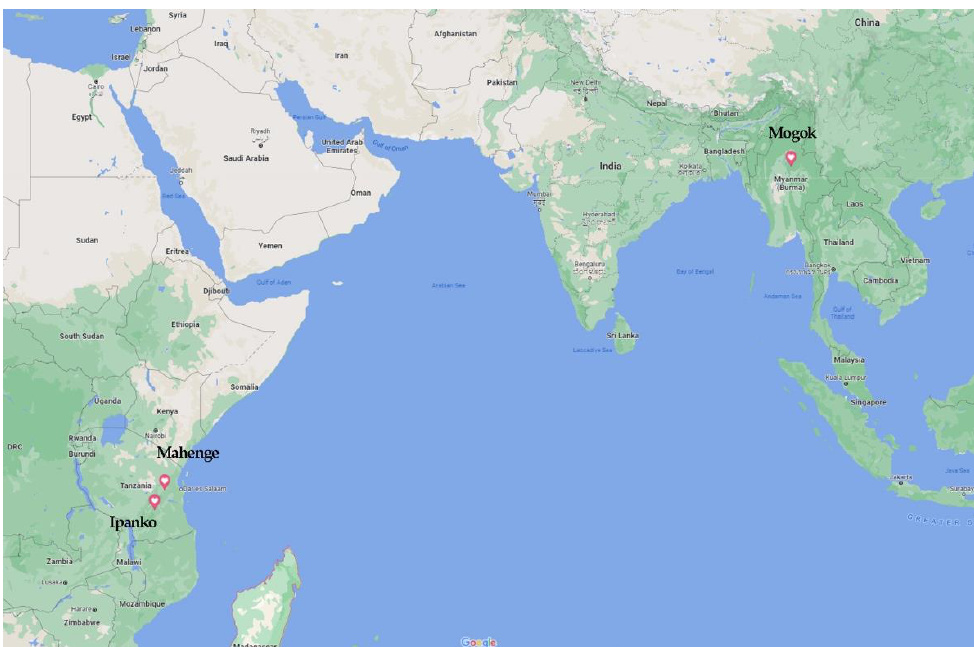
Figure 2. Map of spinel locations in Tanzania and Myanmar (modified from Google Earth).